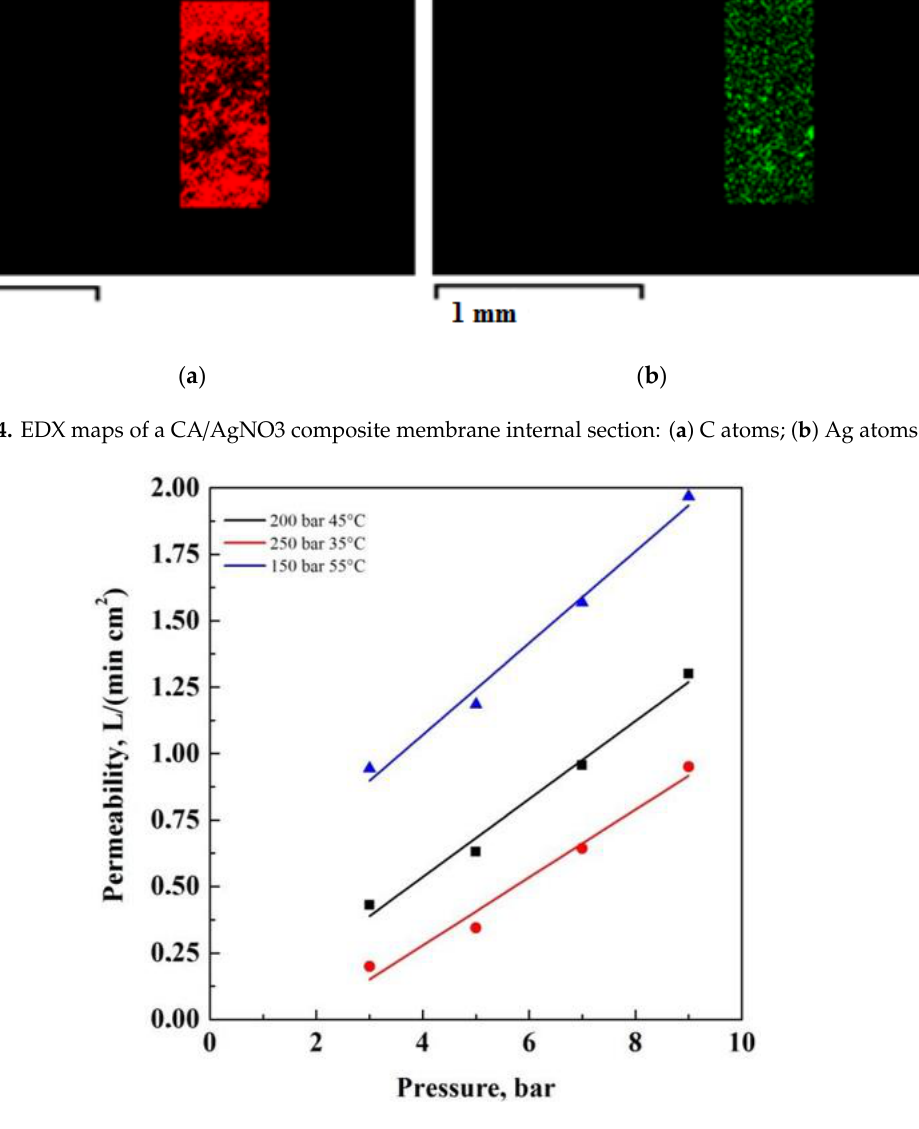
Figure 5. Nitrogen permeability tests performed on 20%(w/w) CA membranes with 0.1%(w/w) AgNO 3 , obtained at 150 bar 55 °C, 200 bar 45 °C, 250 bar 35 °C.